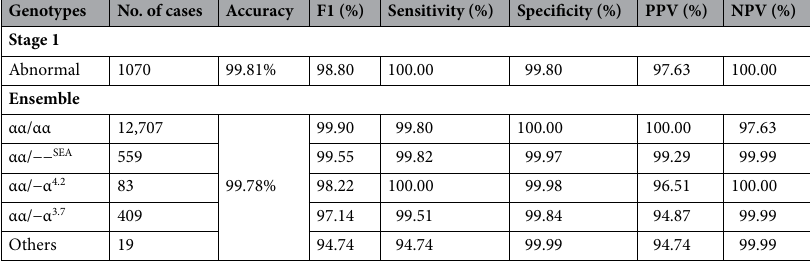
Table 2. Performance metrics of the model on the testing dataset (total case number = 13,777).